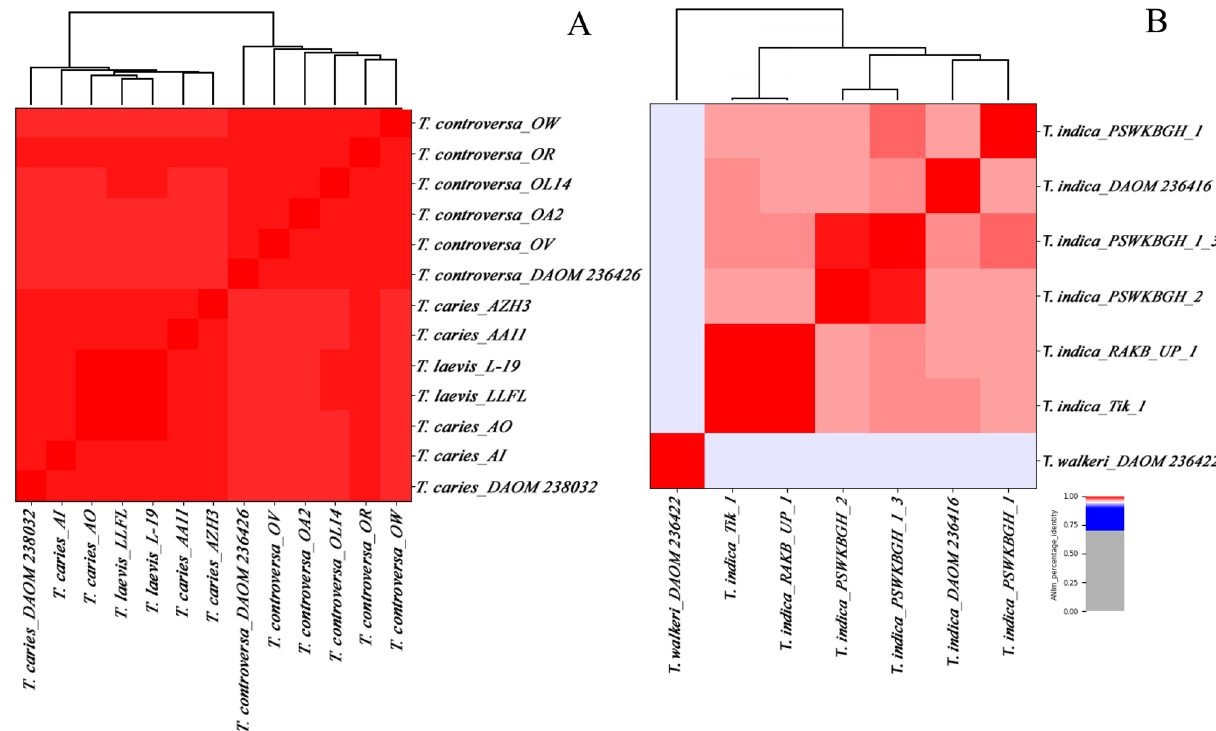
Figure 1. Heatmaps of ANIm percentage identity between genomes of Tilletia spp. Pairwise average nucleotide identity between two groups of Tilletia species (( A ) T. caries , T. controversa , and T. laevis , ( B ) T. indica and T. walkeri ) were determined by Pyani and used for the construction of a single linkage dendrogram. The isolates and species assignments are given as row and column labels. The value of the cophenetic correlation coefficient of the hierarchical clustering was 0.97 for ( A ) and 0.99 for ( B